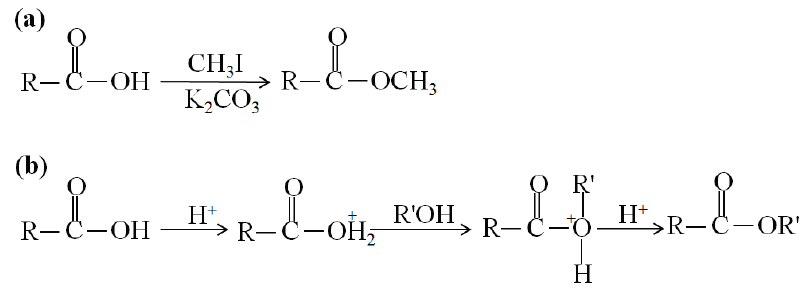
Figure 2. Reaction scheme for the derivatization of fatty acids. ( a ) Esterification of a fatty I and ( b ) acid-catalyzed esterification of a fatty acid by CH 3